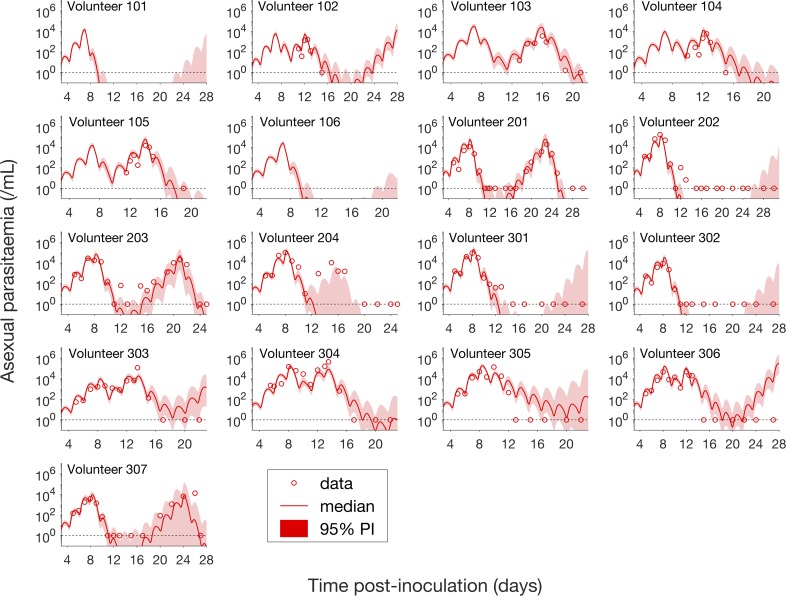
Comparison of model predictions and clinical data for the asexual parasitemia for all 17 volunteers.Data are presented by circles. The median of posterior predictions (solid curve) and 95% PI (shaded area) are generated by 5000 model simulations based on 5000 samples from the posterior parameter distribution as described in the Materials and methods. The data points with one parasite/mL (i.e., those points which lie on the dotted line) indicate measurements for which no parasites were detected. No data are available for Volunteer 101 and 106 to validate the model predictions. The source data and computer code with instructions of implementation to generate Figure 2 are fully publicly available at https://doi.org/10.26188/5cde4c26c8201.